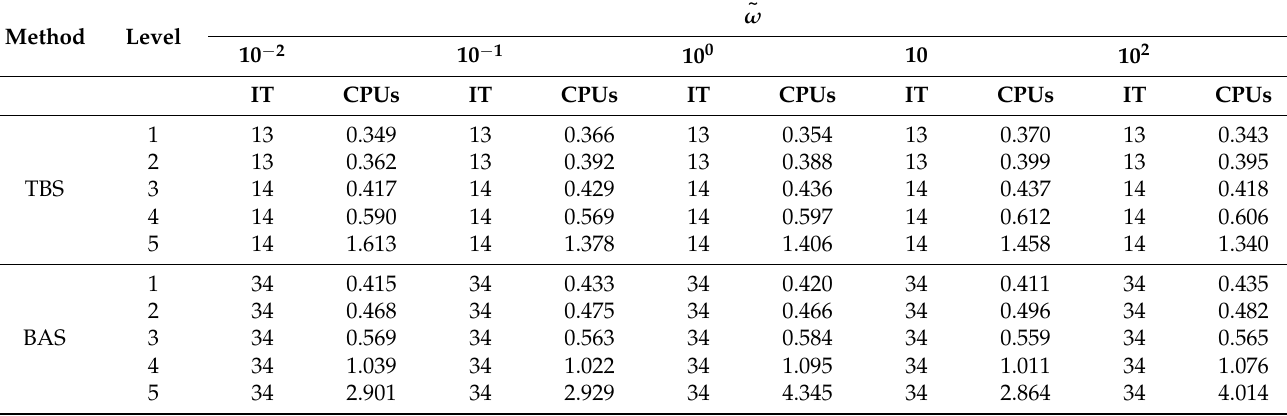
Table 7. Different mesh refinement levels and (cid:101) ω , the results of the iteration method in the 2D case, with ε = 10 − 2 . Method